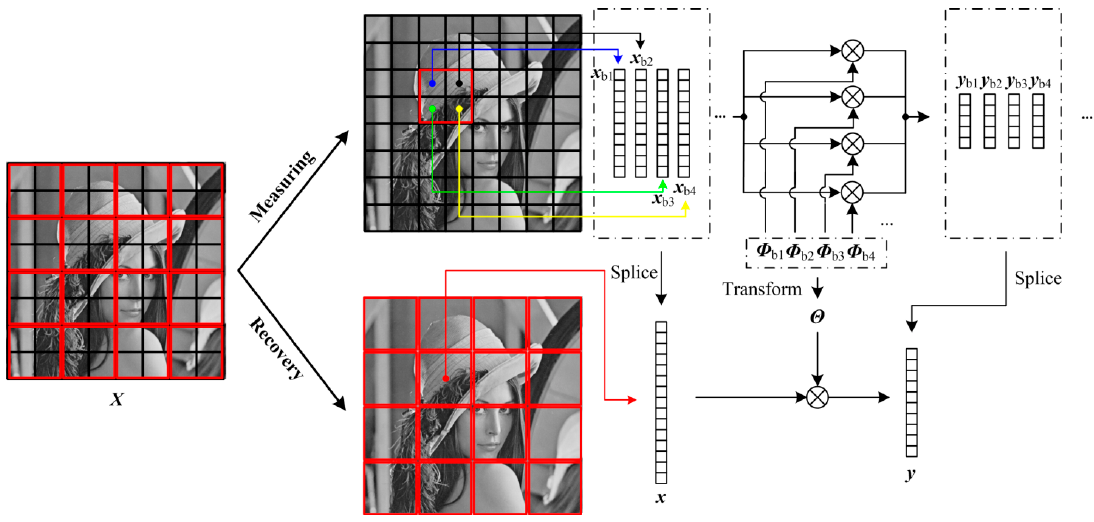
Figure 5. Illustration on LA format. The block-size pair is ( B 1 , B 2 ), and B 2 / B 1 is 2.